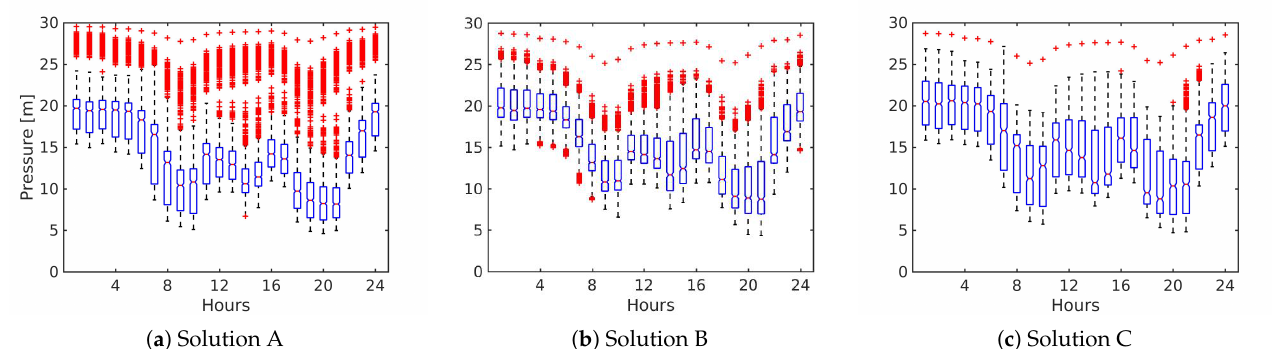
Figure 12. Temporal variation of pressure for solution A, B and C for MLN network. Each time step represents a box plot for the pressure of all nodes of the